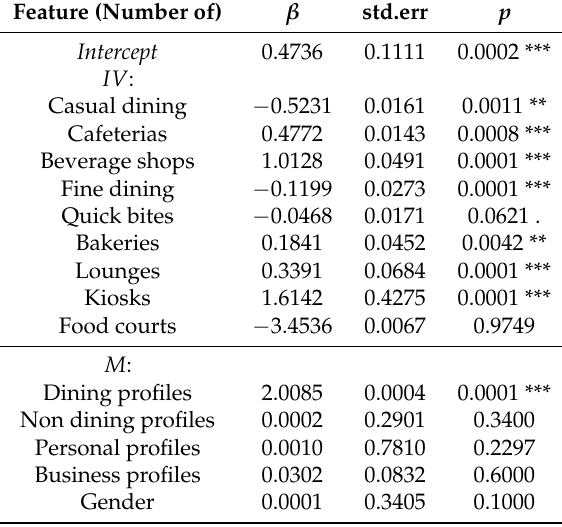
Table A3. Summary of regression results of mediation analysis: independent variables ( IV ), mediator variable ( M ) and dependent variable ( DV ) being dining posts made during the evening ( DV evening ) after 6:00 p.m. The results for IV are presented with Dining profiles as the mediator